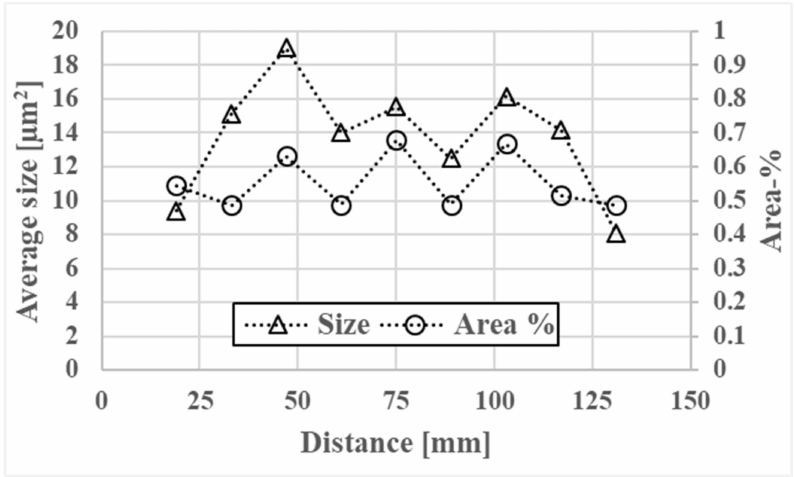
Figure 13. Average area and area fraction of